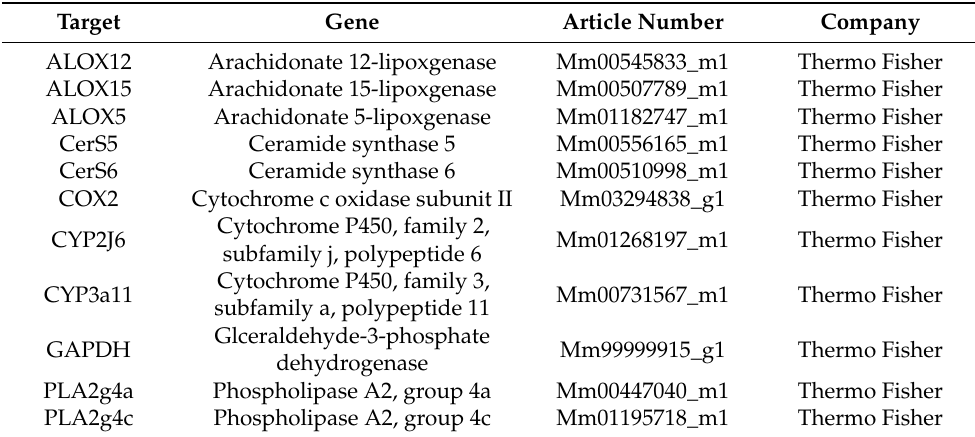
Table 1. List of used TaqMan ® Gene Expression